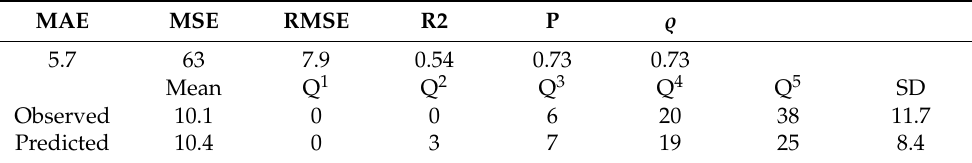
Table 3. Accuracy metrics computed from observed and predicted values of test samples (30%).